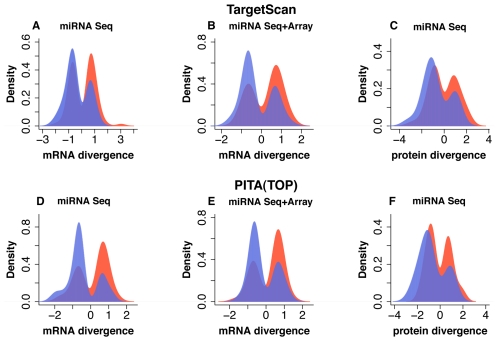
Effect of miRNA expression differences between humans and chimpanzees on mRNA and protein expression in prefrontal cortex.A-F, Distributions of expression divergence measurements (log2-transformed fold-change) for genes targeted by miRNA differently expressed between human and chimpanzee prefrontal cortex. Shown are: mRNA divergence distributions for 139 genes (A) and 106 genes (D), targeted by 37 miRNA classified as differently expressed based on high-throughput sequencing; mRNA divergence distributions for 97 genes (B) and 92 genes (E), targeted by 12 miRNA classified as differently expressed based on sequencing, as well as detected and showing consistent direction of expression difference on the microarrays; protein divergence distributions for 78 genes (C) and 64 genes (F) targeted by 37 miRNA classified as differently expressed based on high-throughput sequencing. Panels (A), (B) and (C) show target genes predicted using the TargetScan5 algorithm; panels (D), (E) and (F) - target genes predicted using PITA (TOP). The colors indicate genes targeted by miRNA that are: blue – miRNA highly expressed in human prefrontal cortex; red – miRNA highly expressed in chimpanzee prefrontal cortex. For both mRNA and protein divergence, positive values indicate higher gene expression in the human brain. Note that targets of highly expressed miRNA tend to show lower expression in the corresponding species. The purple areas show overlap between red and blue distributions. mRNA divergence is displayed as log2-transformed fold-change measurements between human and chimpanzee prefrontal cortex. Protein divergence is displayed as effect size measurements between human and chimpanzee prefrontal cortex.